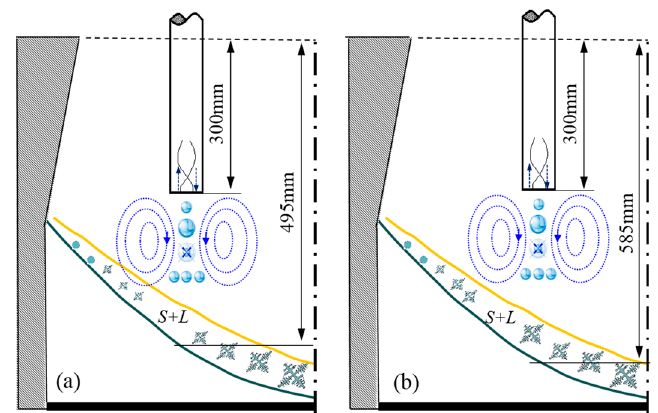
Figure 11. Ultrasonic mechanism of two Φ 1250-mm groups. ( a ) Casting ingot I, ( b ) casting ingot II.